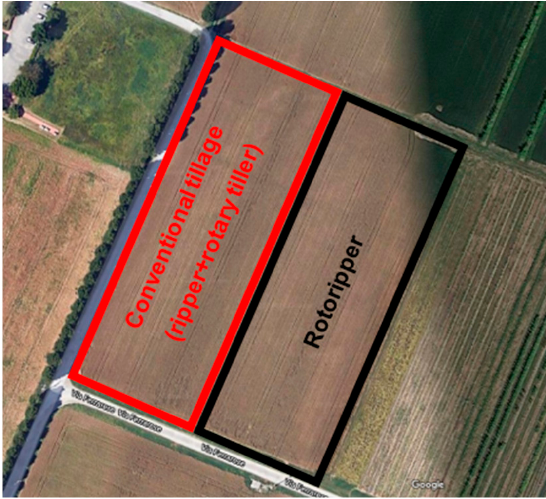
Figure 3. Field used for the tests. Half of the field, the one marked in red colour, was tilled with both ripper and rotary tiller, while the other half, the one marked in light blue colour, was tilled only with the Rotoripper.